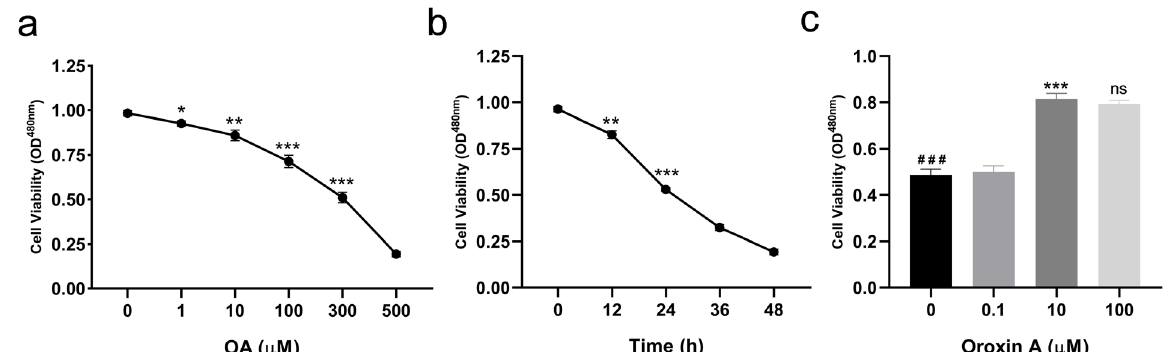
Figure 1. The effects of OA on the A549 cell viability at different concentrations and at different times of stimulation. The effect of OA on the A549 cell viability was dose-dependent and time-dependent, corresponding to 24 h and 300 μM, respectively (a, b). Oroxin A can protect the A549 cells stimulated by OA at a concentration of 10 μM (c). All data were expressed as mean ± SEM. Statistical significance was analyzed by Student’s t test. * p <0.05, ** p <0.01, *** p <0.001 compared with 0 group, ### p <0.001 compared with 100 group, ns means p >0.05 compared with 10 group, n=3 in each